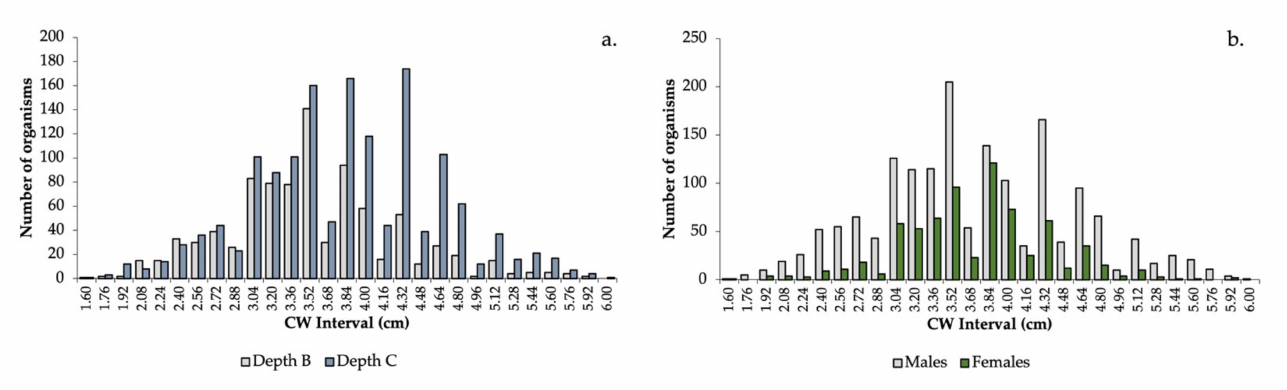
Figure 4. Length frequency histogram obtained by depth ( a ) and sex ( b ) intervals for Achelous spinicarpus